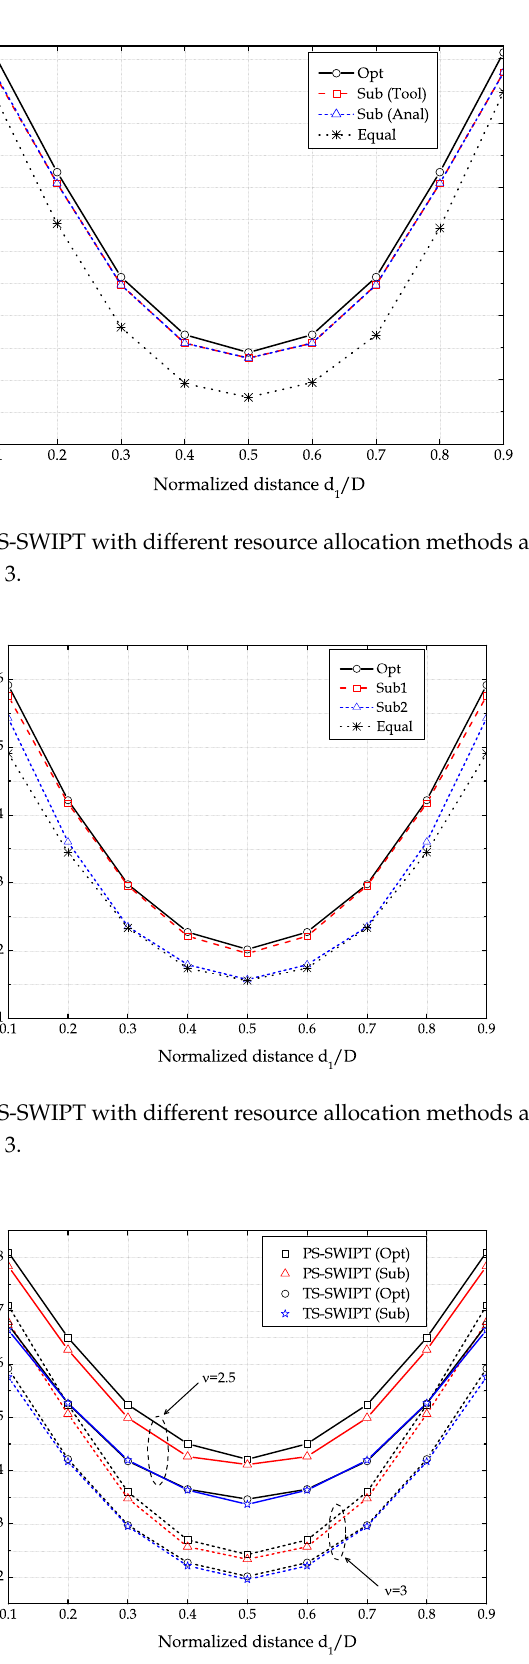
Figure 6. Sum rate of the PS-SWIPT and the TS-SWIPT as a function of d 1 / D when P = 20